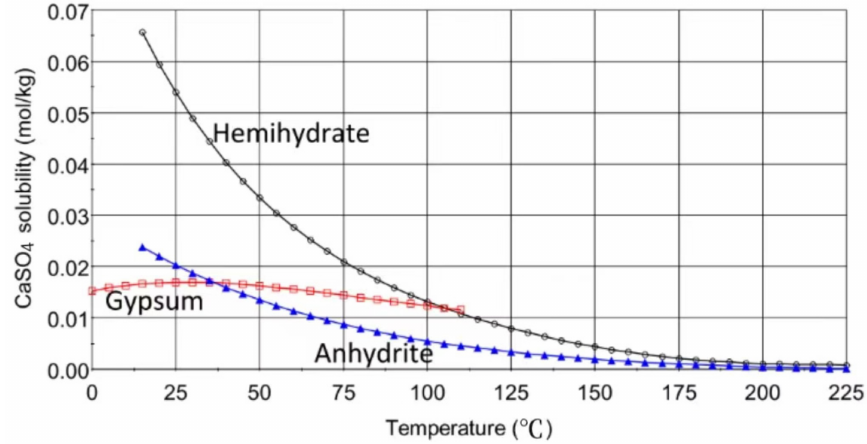
Figure 16. The solubility of CaSO 4 in its three different forms